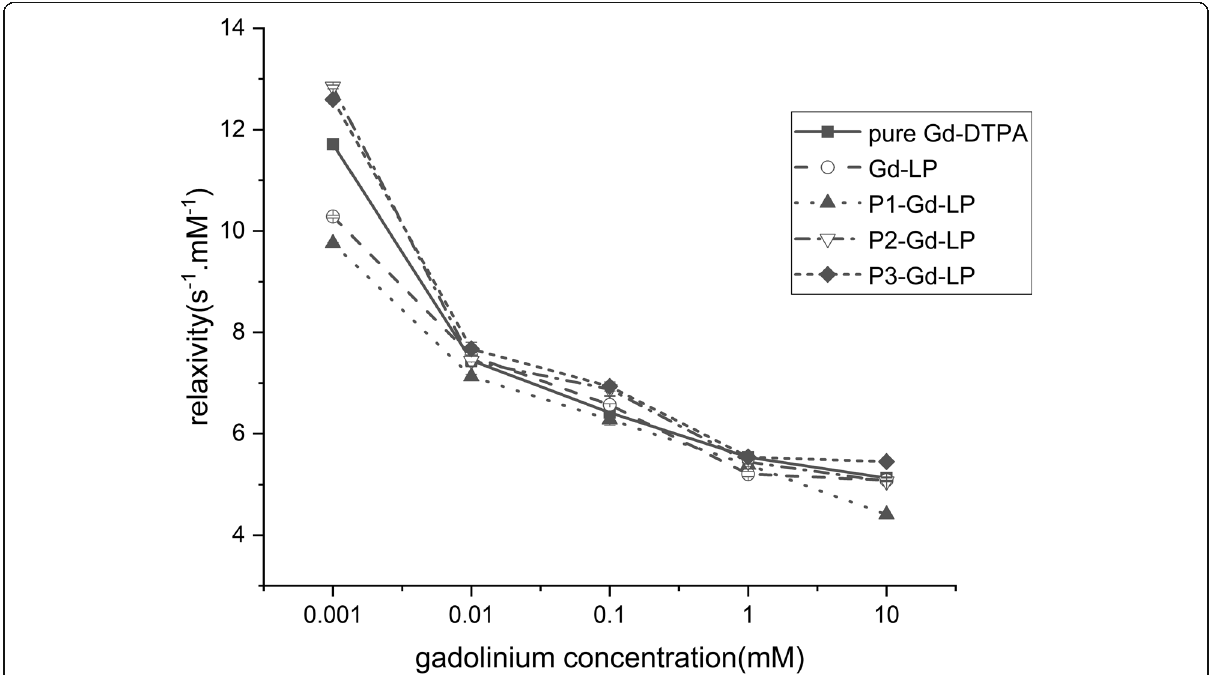
Fig. 1 T1 relaxivity (s − 1 mM − 1 ) of pure Gd-DTPA, Gd-LP, P1-Gd-LP, P2-Gd-LP, and P3-Gd-LP solution measured in different gadolinium concentrations (mM). The data represent the mean ± standard deviation ( n = 3), ( P >